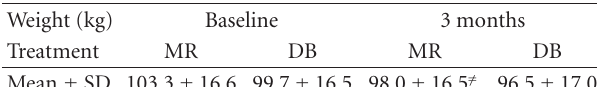
Table 2: Subjects who completed 3